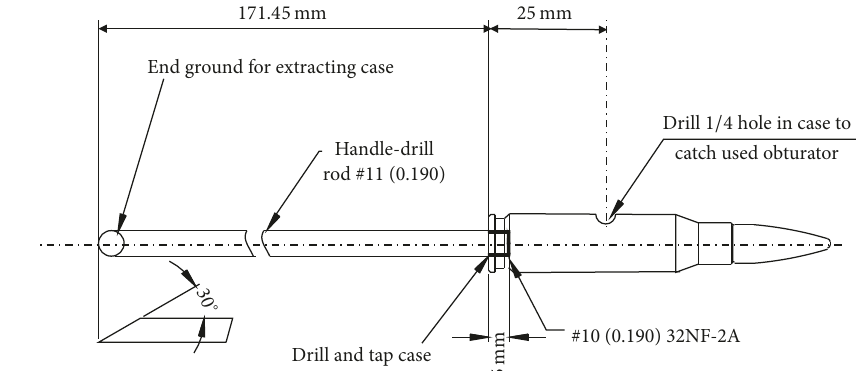
Figure 2: Drawing for preparing proof cartridge [ 05 ].